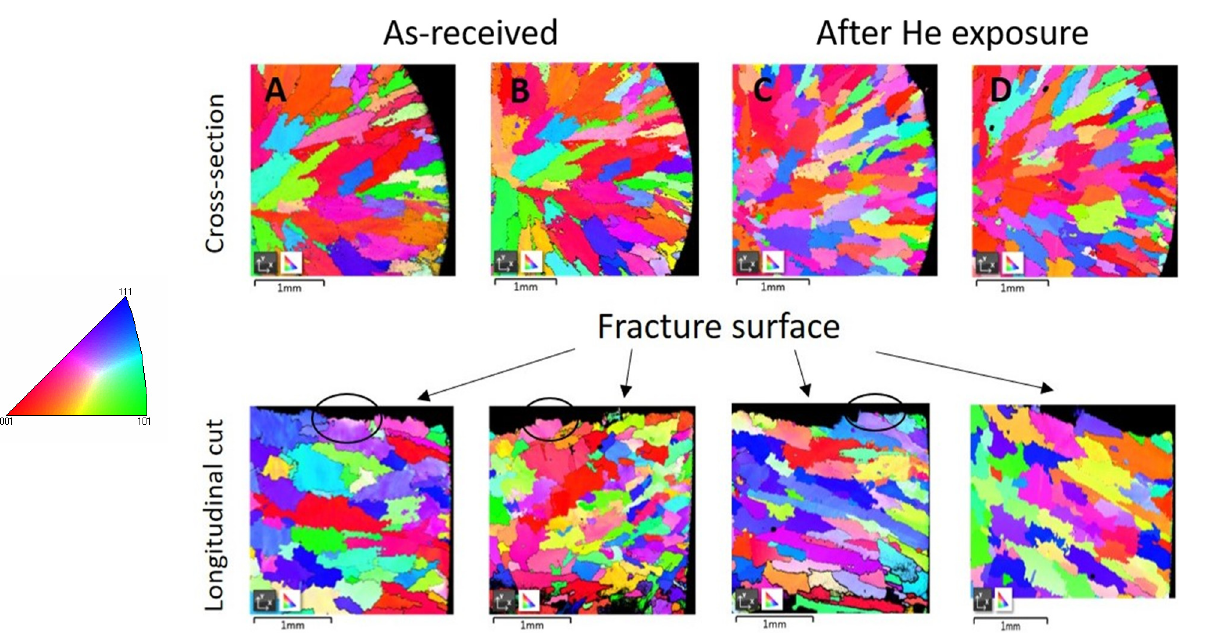
Figure 2. EBSD mapping of IN738 after tensile testing in Euler angles: ( a ) as-received 50R, cross- section (up), longitudinal (down); ( b ) as-received 100R, cross-section (up), longitudinal (down); ( c ) after He exposure, cross-section (up), longitudinal (down); ( d ) after He exposure, cross-section (up), longitudinal (down). Recrystallized structure is marked by black ellipses. On the left is a legend for IPF coloring.